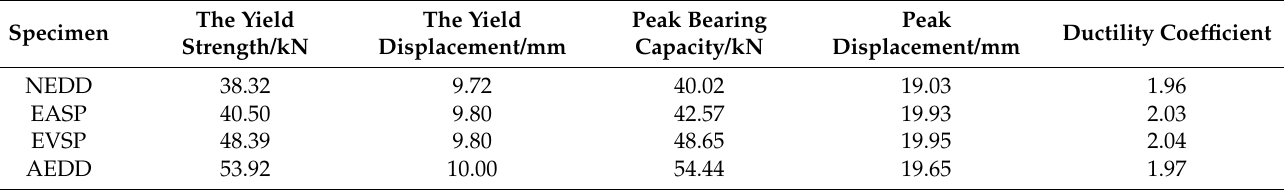
Figure 14. Skeleton curves of different types of piers. Table 4. Performance turning point of skeleton curve.